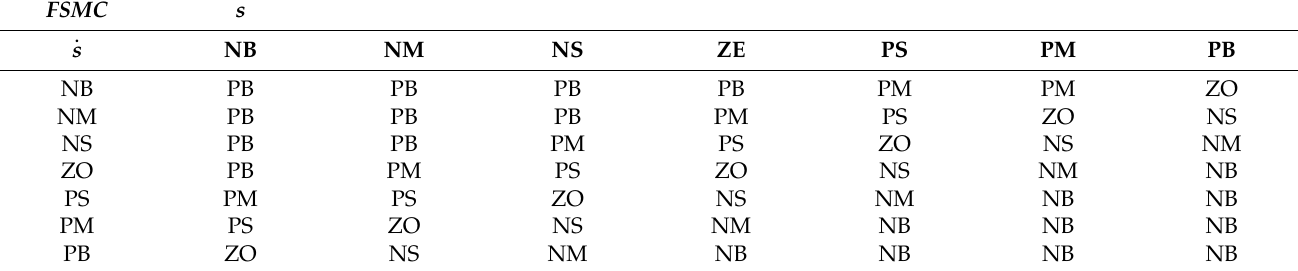
Table 1. Fuzzy rules for FSMC.